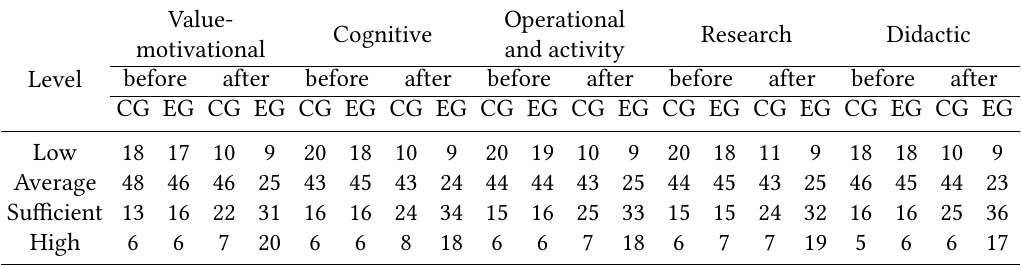
Table 4 Levels of formation of digital competence of CS bachelors in the use of CBLE in control (CG) and experimental (EG) groups (before and after the